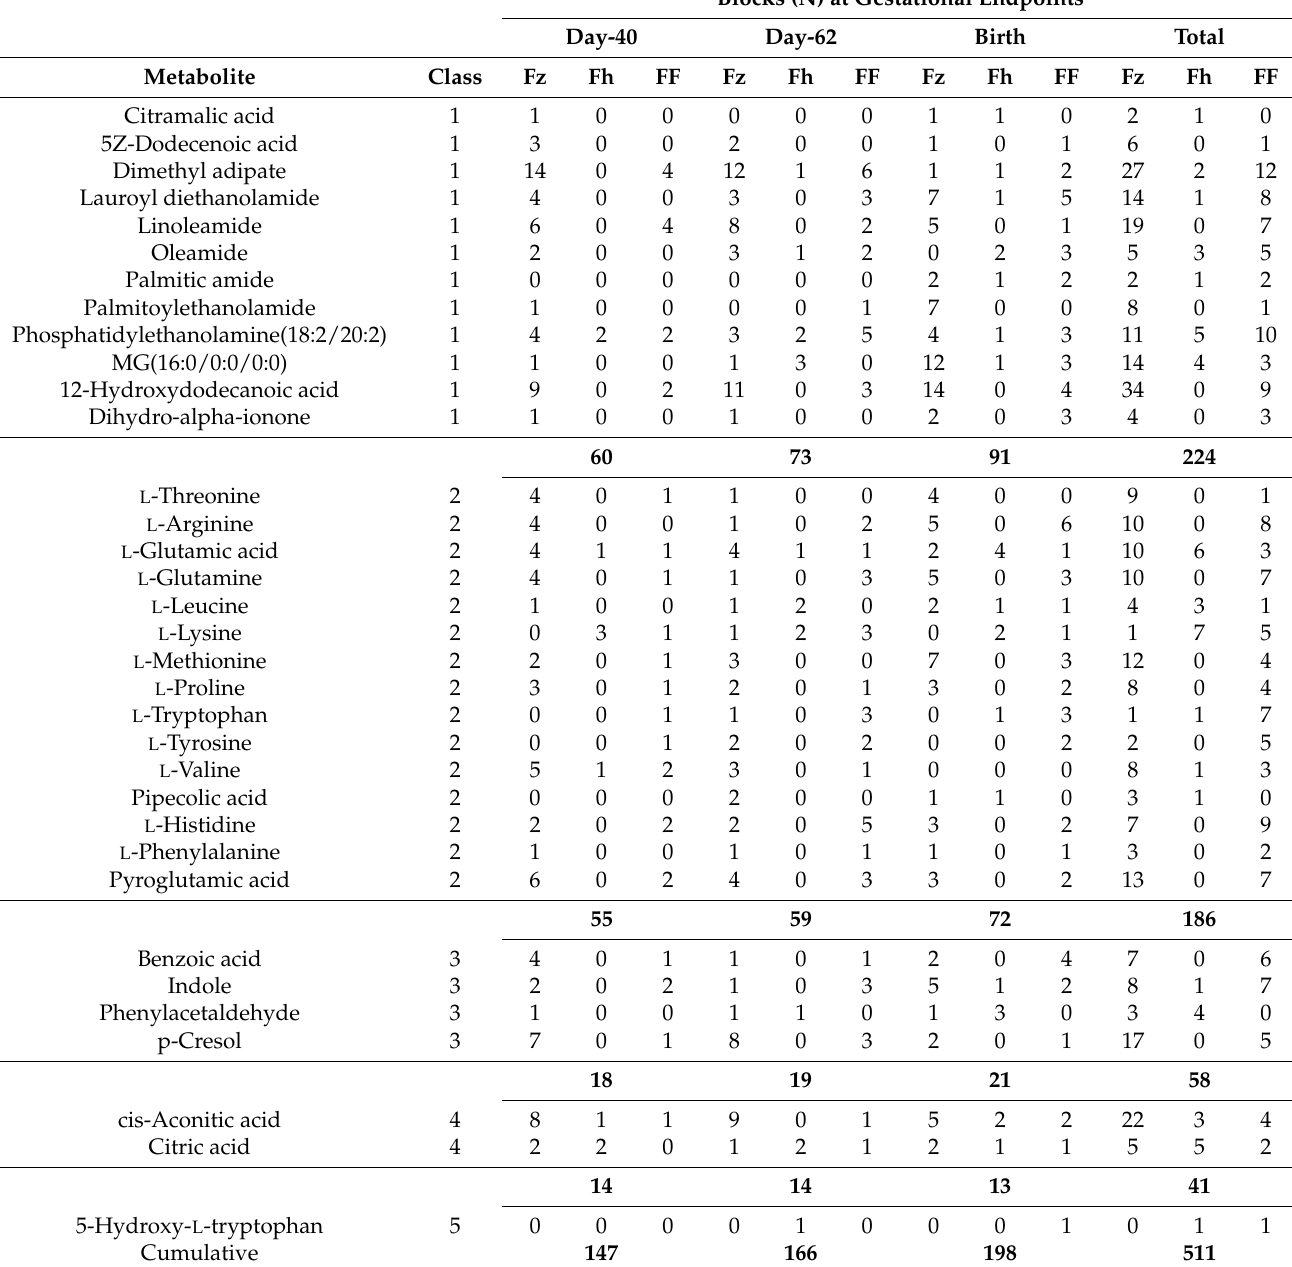
Class metabolite analysis in all identified blocks. Metabolites were grouped into five taxonomical classes identified in total blocks at the three developmental endpoints (Table 3): Class (1) Lipid and lipid-like molecules (224 blocks—the most predictive class; 12 metabolites); Class (2) amino acids (186 blocks; 15 metabolites); Class (3) benzenoids (58 blocks; 4 metabolites); Class (4) Tricarboxylic acids (41 blocks; 2 metabolites); and Class (5) Tryptamines and derivatives (2 blocks; 1 metabolite) (metabolite subclasses are defined in Supplementary Table S2). Table 3. Taxonomical classification (Classes were lipids—1, amino acids and derivatives—2, benzenoids—3, tri-carboxylic acids—4 and tryptamines and derivatives—5) of metabolites identified as significantly predictive within blocks and pregnancy endpoints D40, D62 and Birth (numbers of blocks with Fz: Frozen embryos; Fh: Fresh embryos; FF: Frozen and Fresh